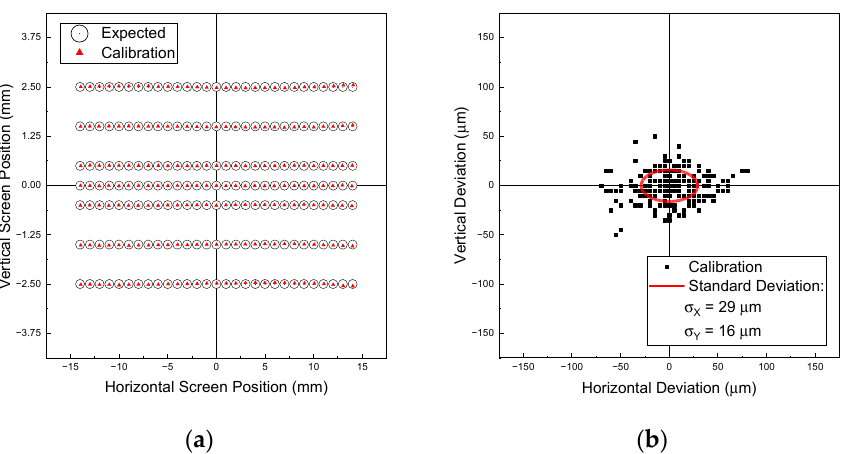
Figure 3. ( a ) Calibrated position on the screen (red) and the set pattern (black); ( b ) Deviations of the set values and the screen calibration (black) and the resulting standard deviation (red).